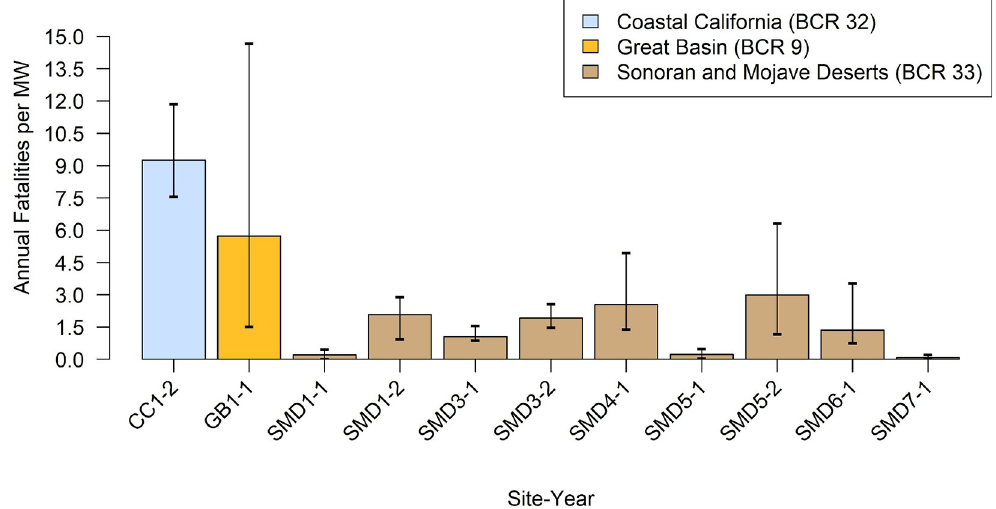
Fig 6. Annual all bird fatality estimates, adjusted for detection probability and search effort, per megawatt (nameplate capacity) by Bird Conservation Region, from January 1, 2013, to September 1, 2018. Vertical bars show 90% confidence interval around estimates for each study except SMD6-1, which only reported a 95% confidence